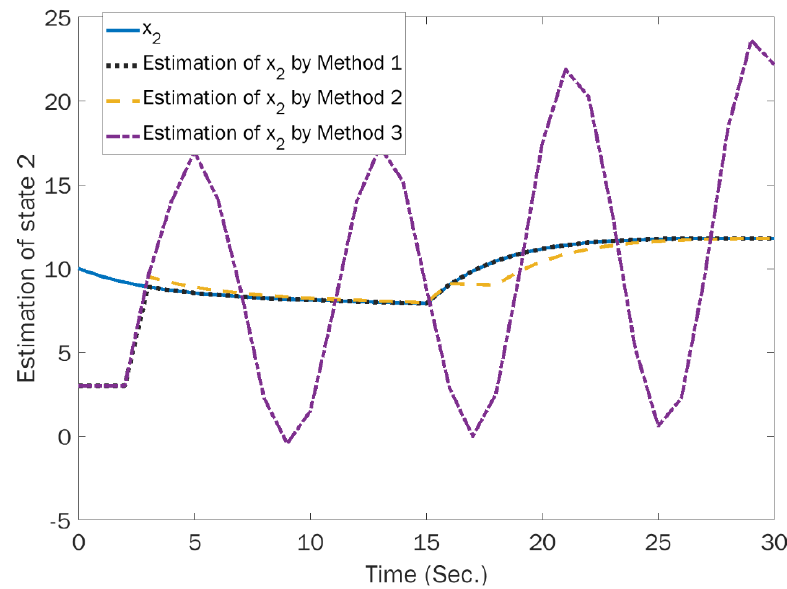
Figure 4. The state 2 estimation results of the three introduced observers.